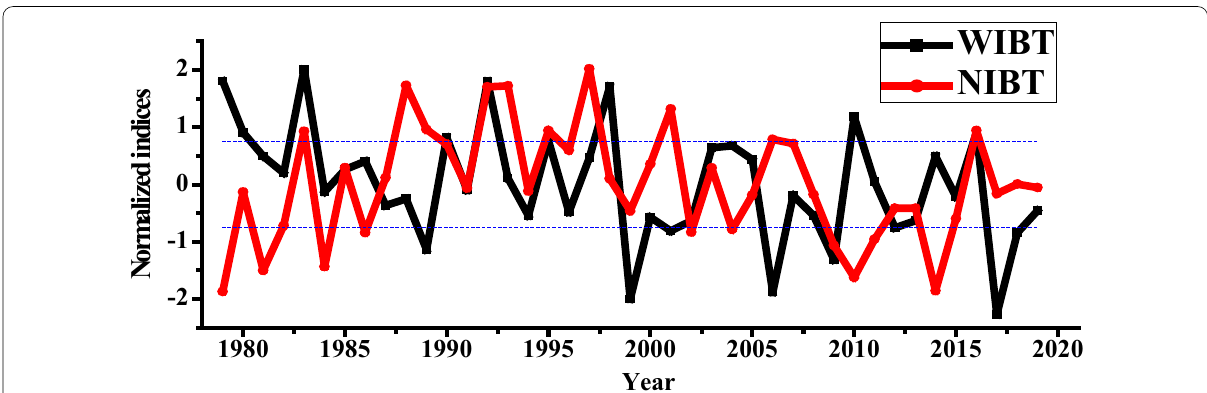
Fig. 4 Time series of the normalized winter (December, January, and February) NIBT (red) and WIBT (black) indices for the period 1979–2019. The blue dashed lines from top to bottom denote